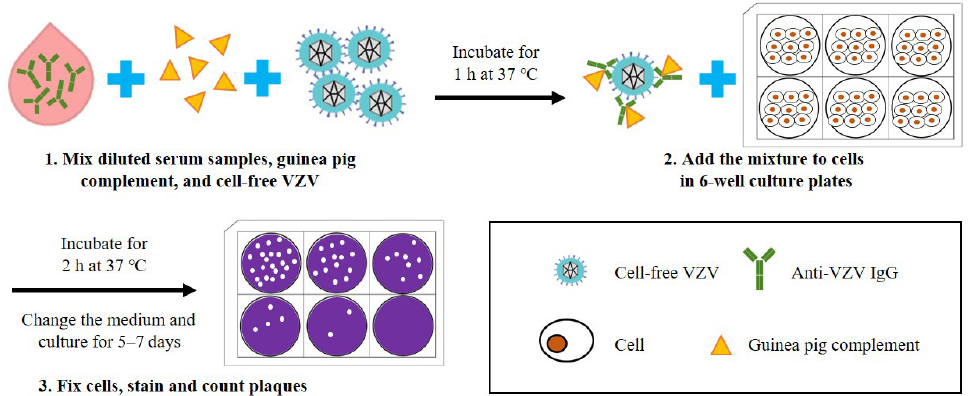
Figure 3. Schematic diagram depicting the basic steps of a neutralization assay for the detection of anti-VZV antibodies. (1) Diluted serum samples, guinea pig complement, and cell-free VZV are mixed and incubated for 1 h at 37 °C. (2) The mixture is added to cells in 6-well culture plates and incubated for 2 h at 37 °C, and then the culture medium is replaced. (3) After culturing for 5 – 7 days, the cells are fixed and stained to visualize the plaques, and the neutralization titer of serum samples can be calculated according to the number of plaques.